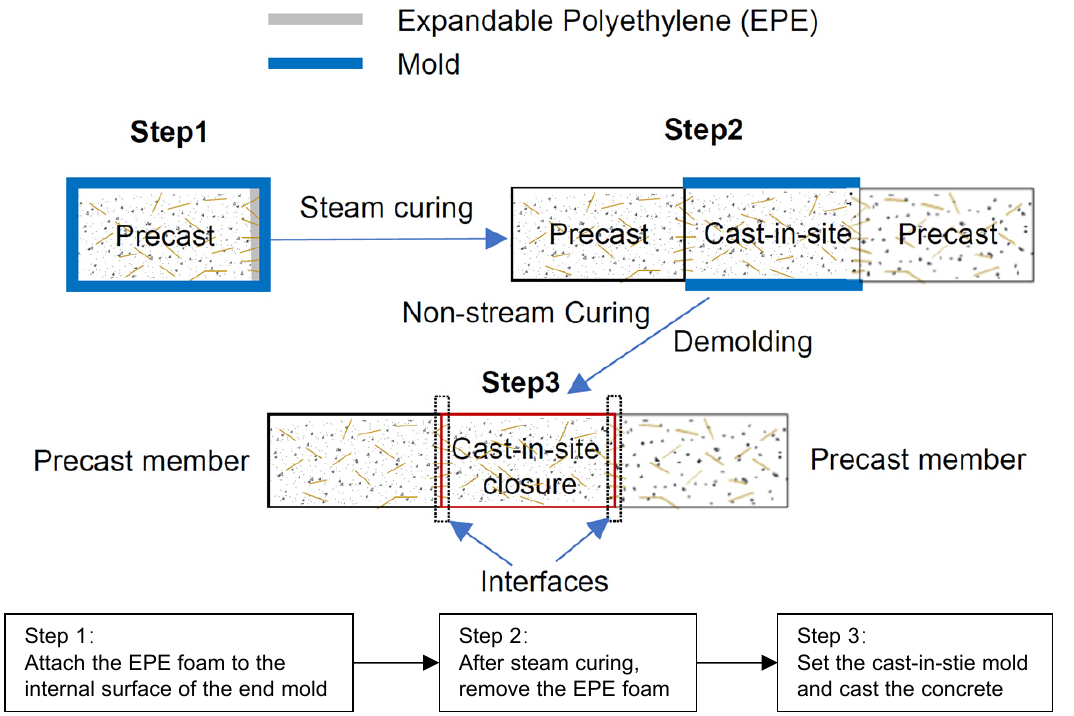
Figure 3. Interfacical improvement technology between precast members and the cast-in-site